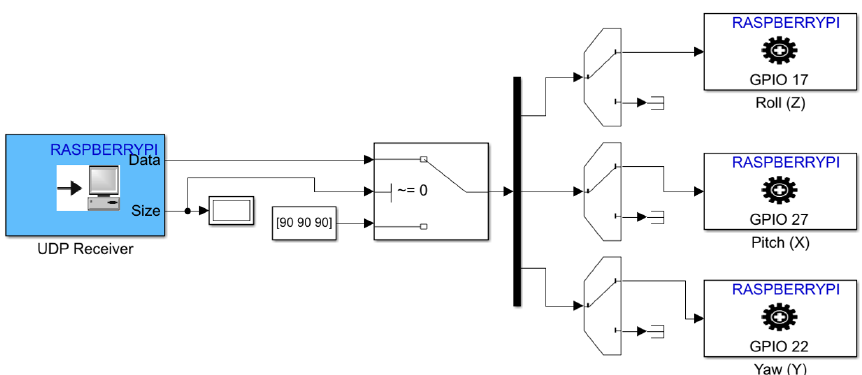
Figure 12. Simulink deployed function on the Raspberry